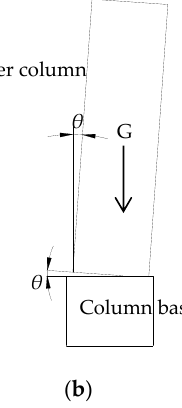
Figure 4. Connection type of Chinese traditional timber structure base: ( a ) Flat pendulum floating column foot; ( b ) A simplified model of tilted timber column.